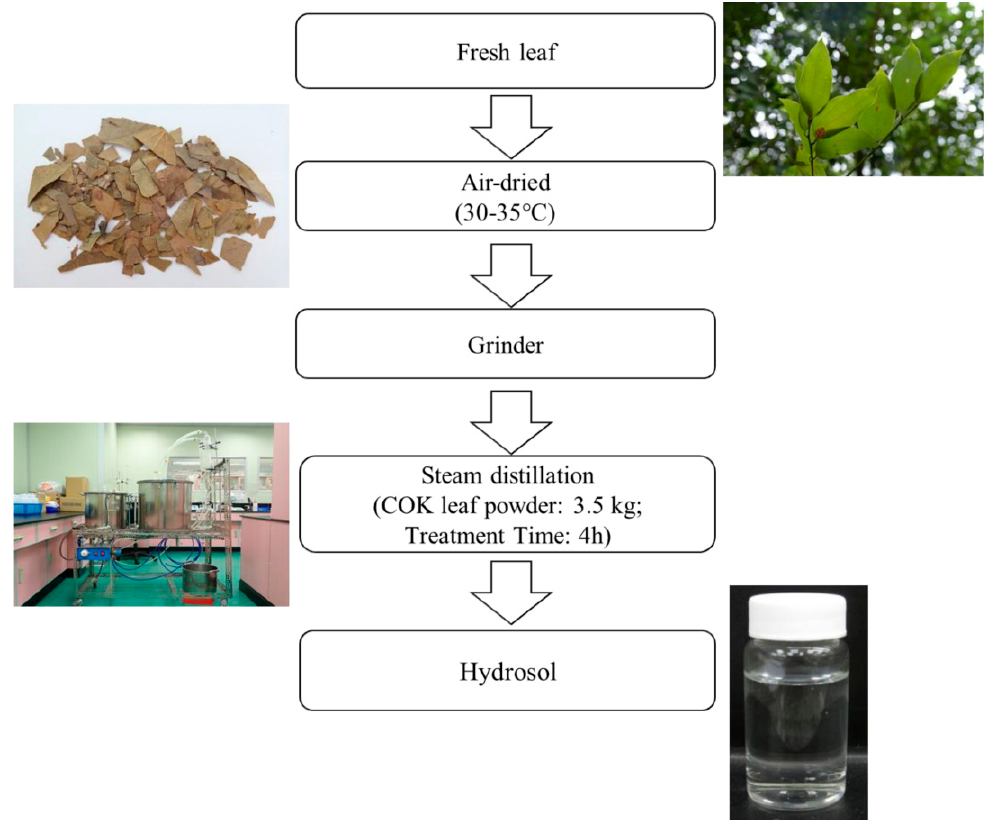
Figure 1. Process for producing hydrosol from Cinnamomoum osmophloeum Kanehira (COK) leaves using steam distillation.